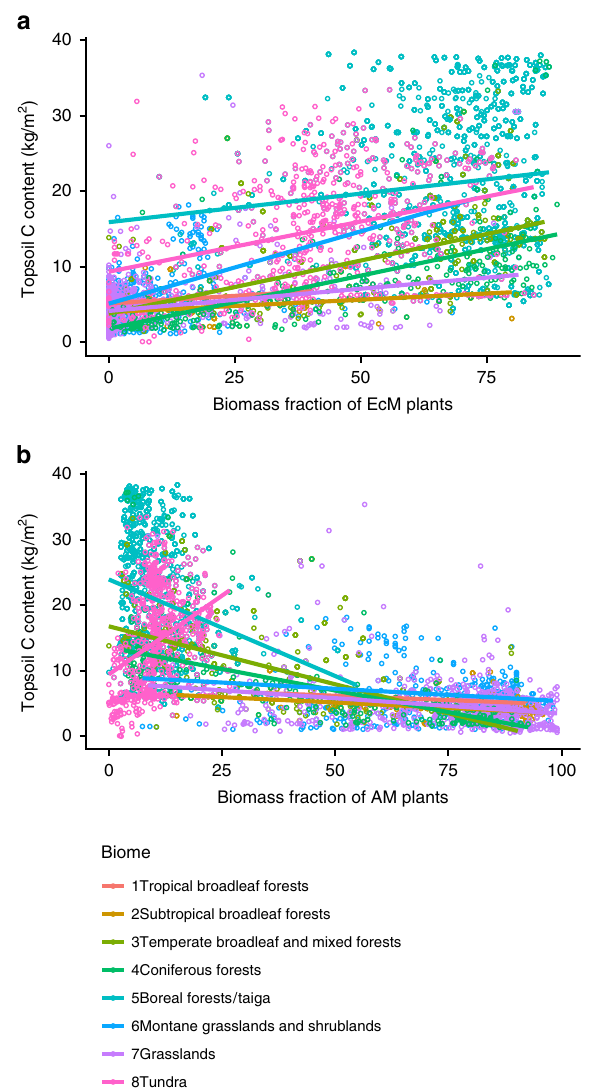
Fig. 4 Quantitative relationships between topsoil (0 – 20 cm) C and biomass fraction of mycorrhizal vegetation in natural ecosystems. a EcM plants and b AM plants. The outcomes of individual models are presented in the Supplementary Table 2. Croplands were excluded from the analysis. Per- biome predictions are shown in different colours. Source data are provided as a Source Data fi